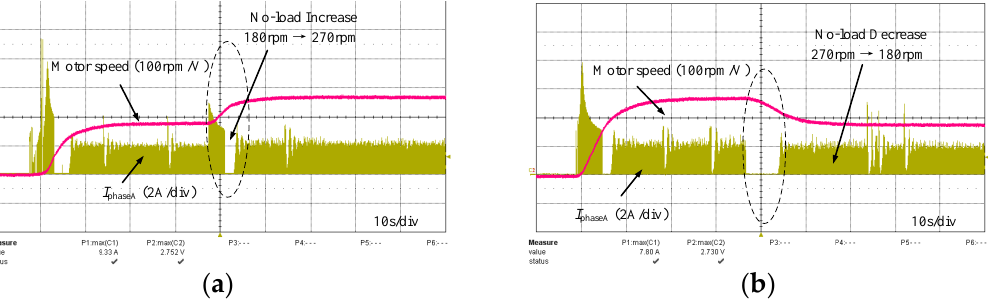
Figure 15. Speed regulation test without load: ( a ) speed increasing; ( b ) speed decreasing.